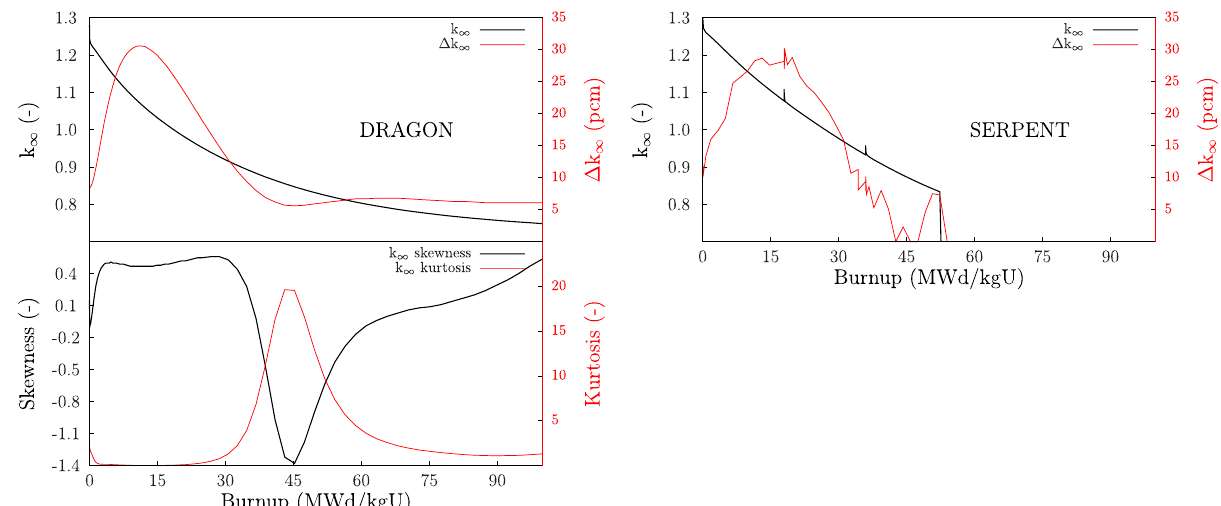
Fig. 2. Calculated k ∞ , with its uncertainty, skewness and kurtosis as a function of the pincell burnup value, using DRAGON and 1000 random cases (left) and SERPENT and 20 random cases